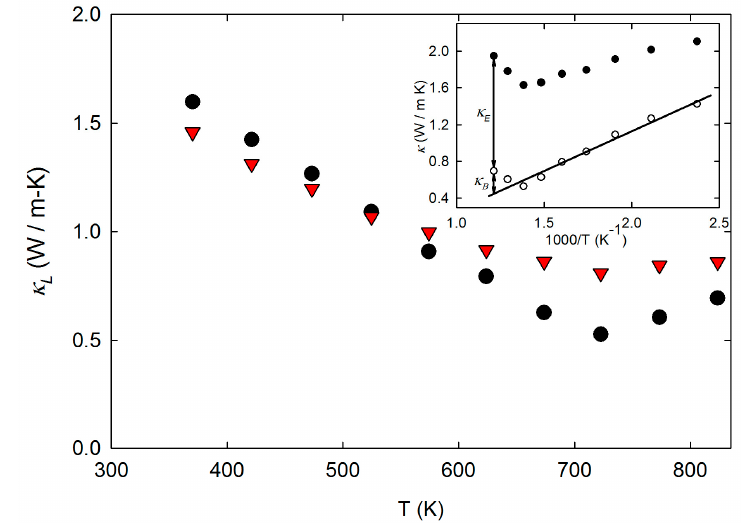
Figure 3. Temperature-dependent κ L for Yb 0.13 In 0.02 Co 3 FeSb 12 (circle) and Yb 0.39 In 0.02 Co 2.4 Fe 1.6 Sb 12 (triangle). The inset illustrates the method used to estimate κ B for both specimens, with Yb 0.13 In 0.02 Co 3 FeSb 12 shown here, where the solid line is the T − 1 dependence between 400 K and 700 K.